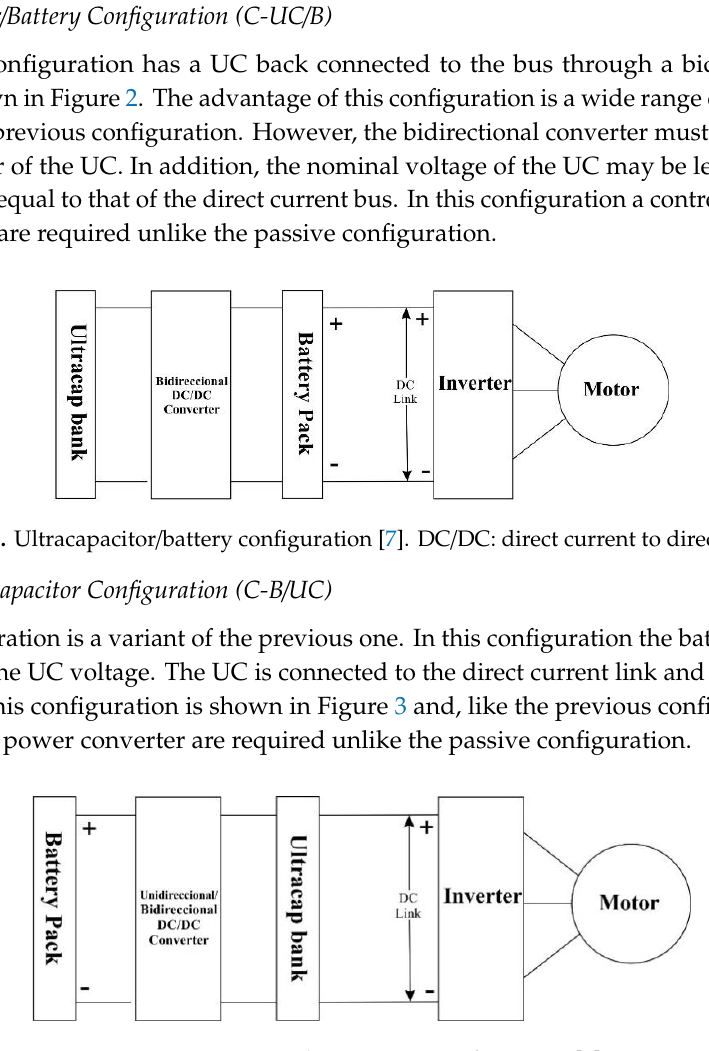
Figure 1. Basic passive parallel configuration [7]. DC: direct current.